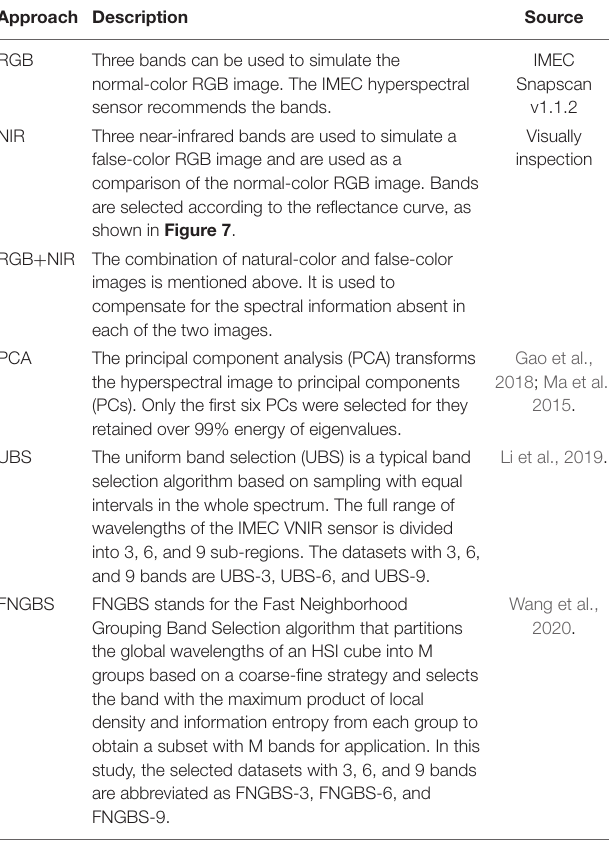
for band selection.